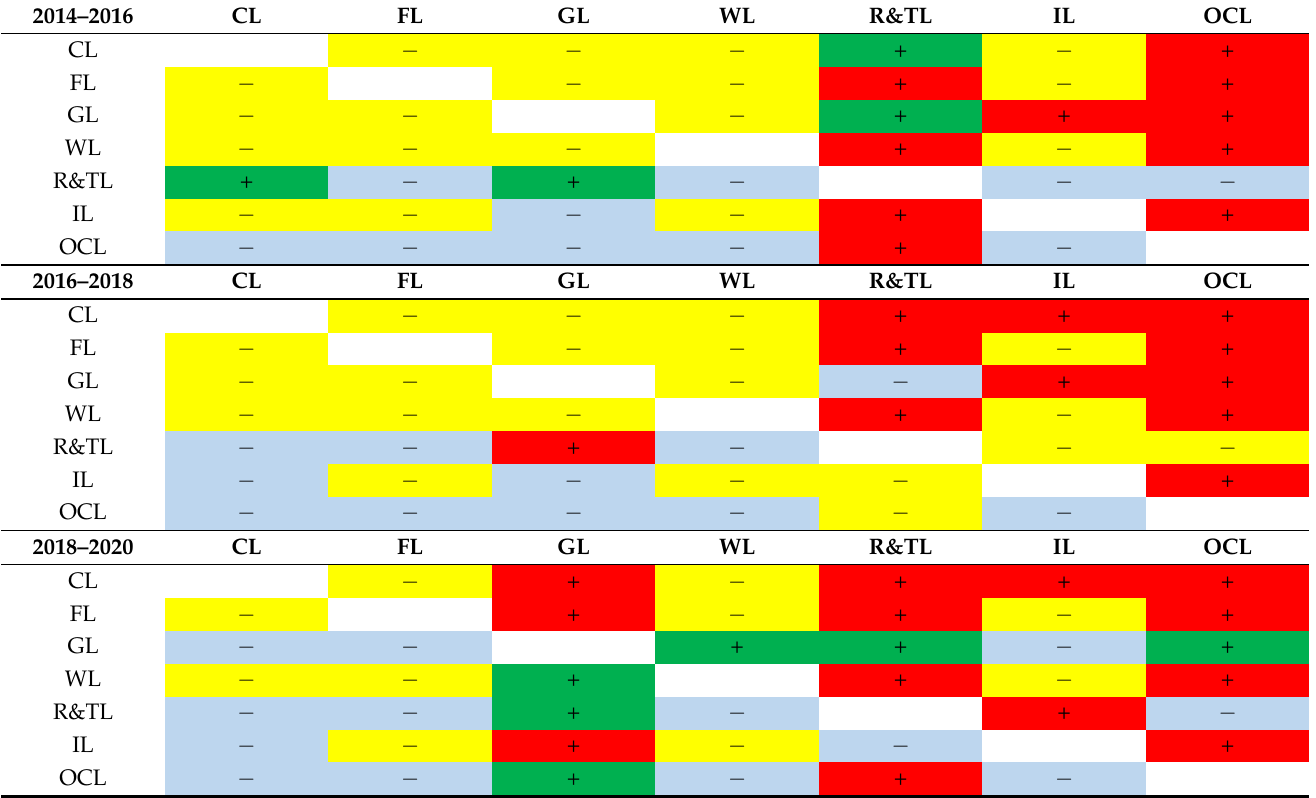
Table 5. Changes in ecological relationships of Tongzhou District.